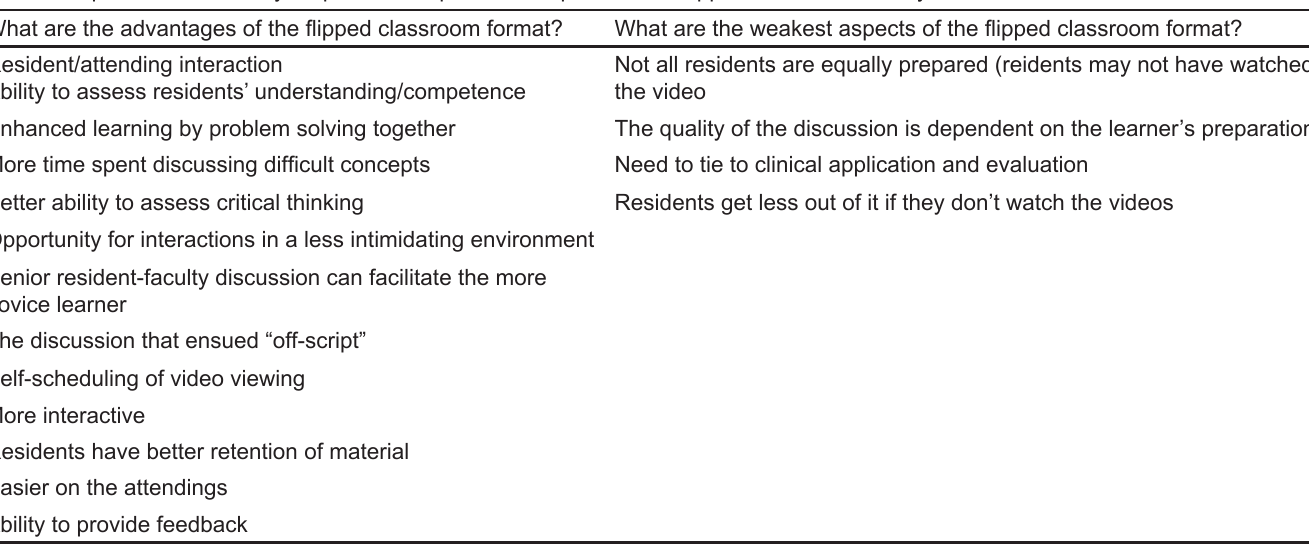
Table 3 . Representative faculty responses to open-ended questions of flipped classroom